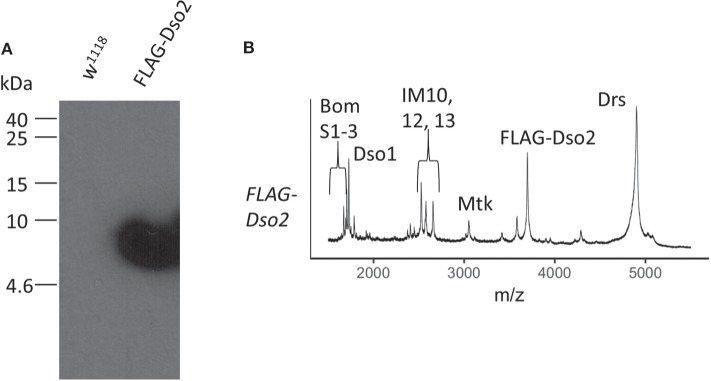
Characterization of FLAG-Dso2 gene product. (A) Immunoblot stained with mouse α-FLAG M2 (1:500) and sheep α-mouse HRP (1:1,000). Two μl of Toll-induced hemolymph was loaded per lane. (B) MALDI-TOF analysis of FLAG-Dso2 Toll-induced hemolymph in linear mode.